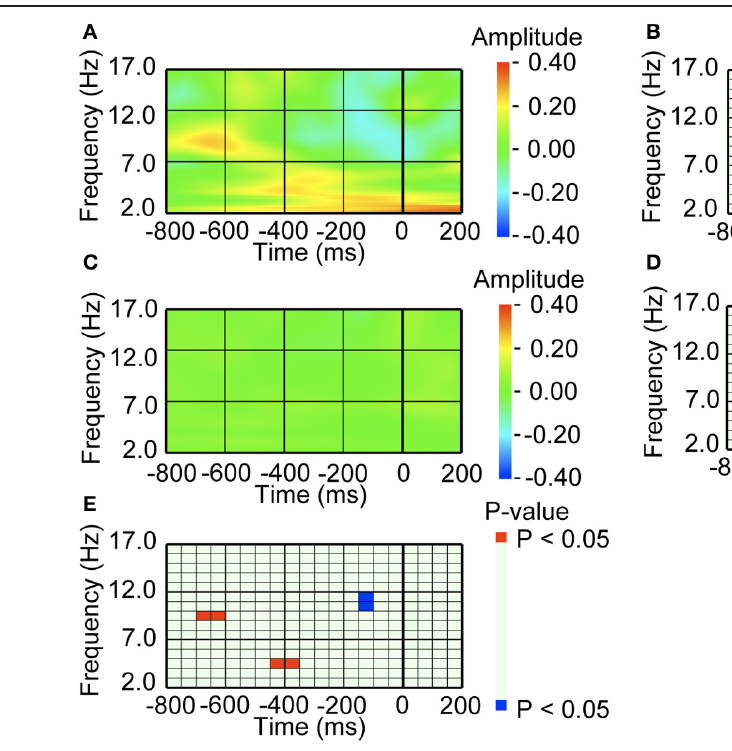
followed by perceptual switching. The amplitude was Z-transformed, and the amplitude zero indicates baseline amplitude. (D) Statistical difference between average waveform aligned with the no-switch saccades and baseline amplitude. The colors red and blue denote that amplitude was larger in average waveform or baseline amplitude, respectively ( P < 0 . 05). (E) Statistical difference between average waveform aligned with pre-switch saccades and average waveform aligned with the no-switch saccades. The colors red and blue denote that amplitude was larger in the pre-switch saccade-related average waveform or the no-switch saccade-related average waveform, respectively ( P < 0 .